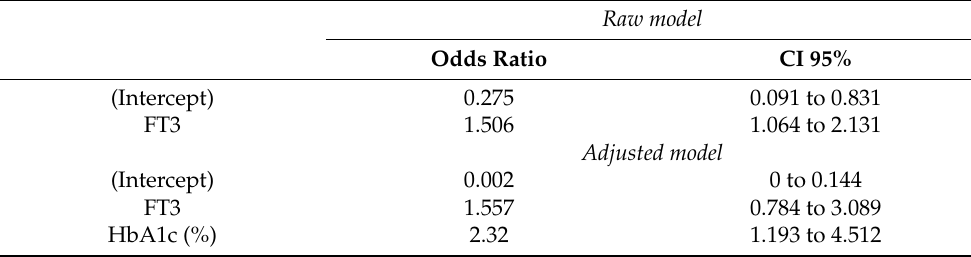
Table 3. Logistic regression model of a high risk of NAFLD according to the FLI